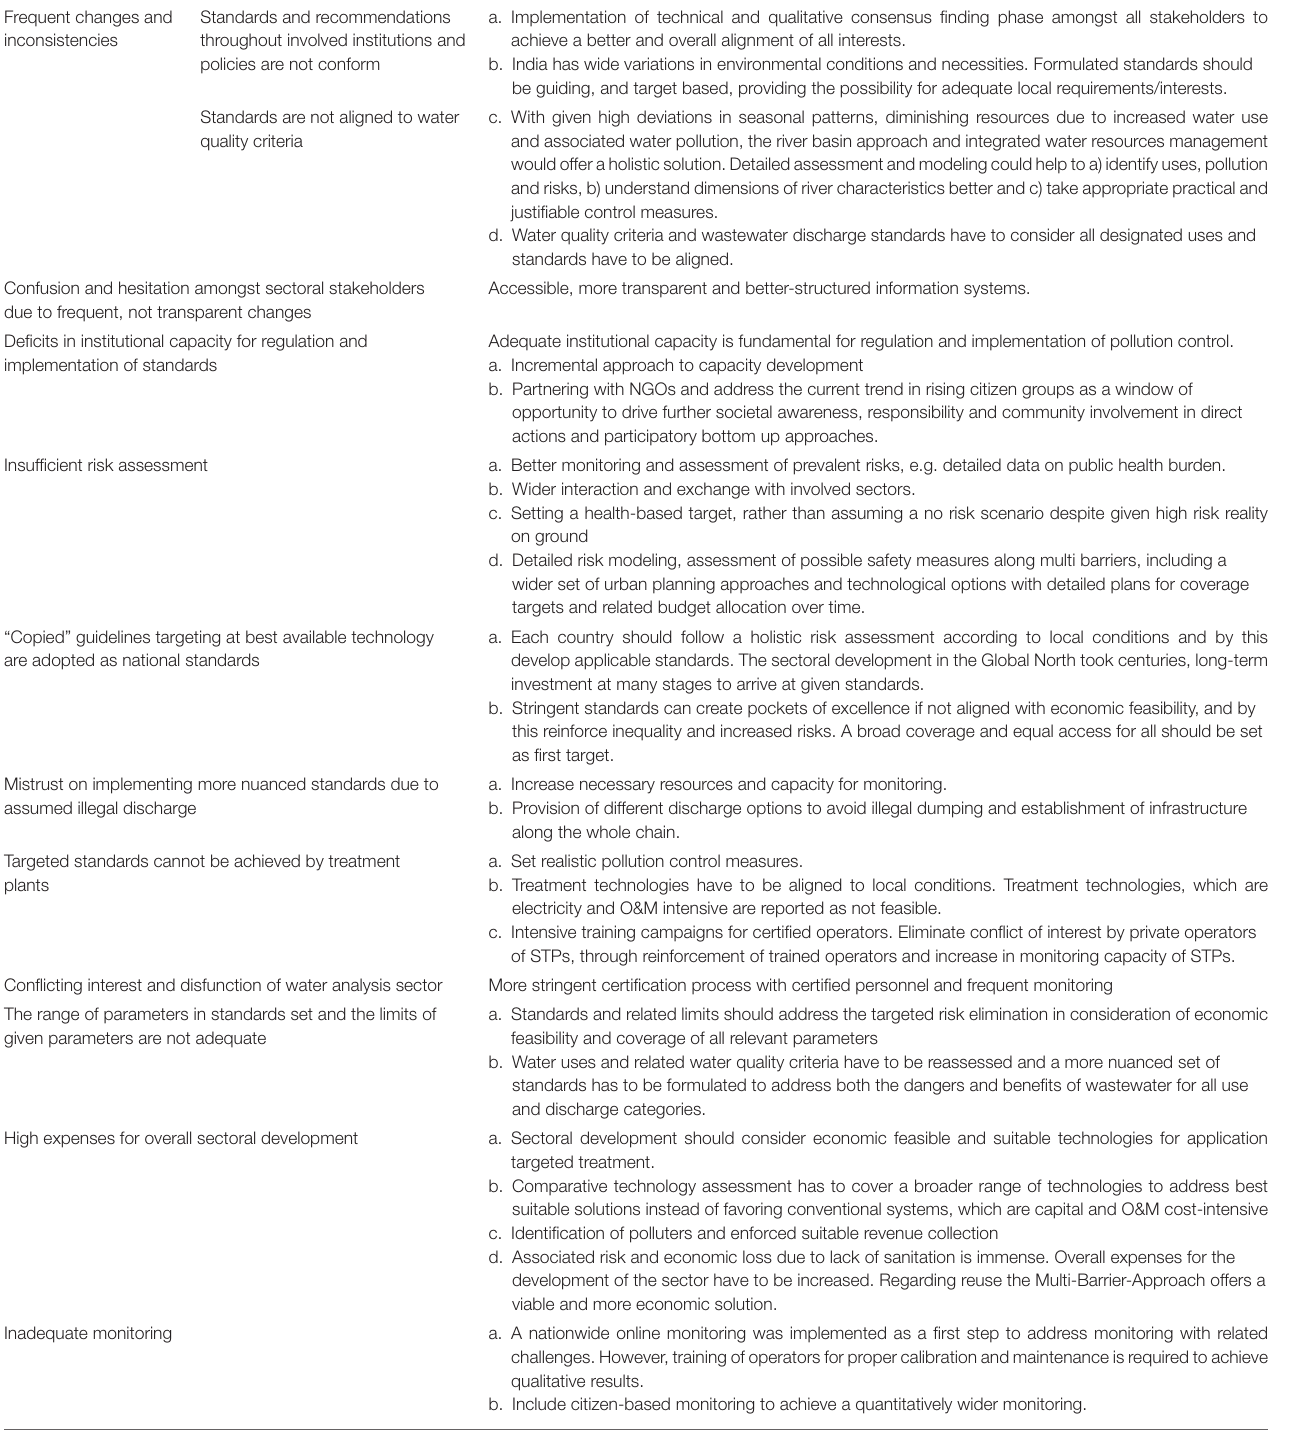
TABLE 10 | Observations and related recommendations for the way